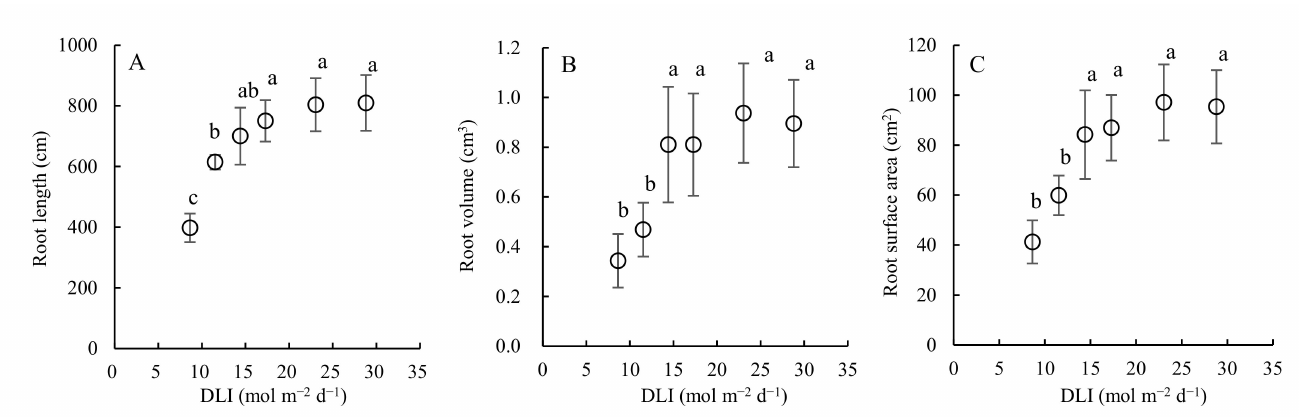
Figure 6. Effect of daily light integrals (DLIs) on ( A ) root length, ( B ) root volume, and ( C ) root surface area of cucumber seedlings at 21 days after sowing in a closed transplant system. Data are presented as mean ± standard deviation. Different letters indicate significant differences at p < 0.05.